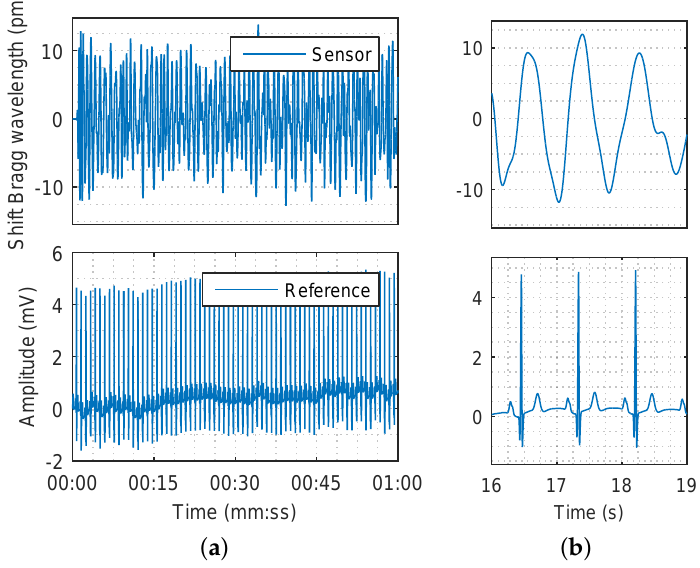
Figure 10. ( a ) The Bragg wavelength shift from sensor corresponding to heart rate ( top ) and Electrocardiography (ECG) reference signal originating from the cardiac electrical activity ( bottom ) for 60 s; ( b ) The detail of the signals for 3